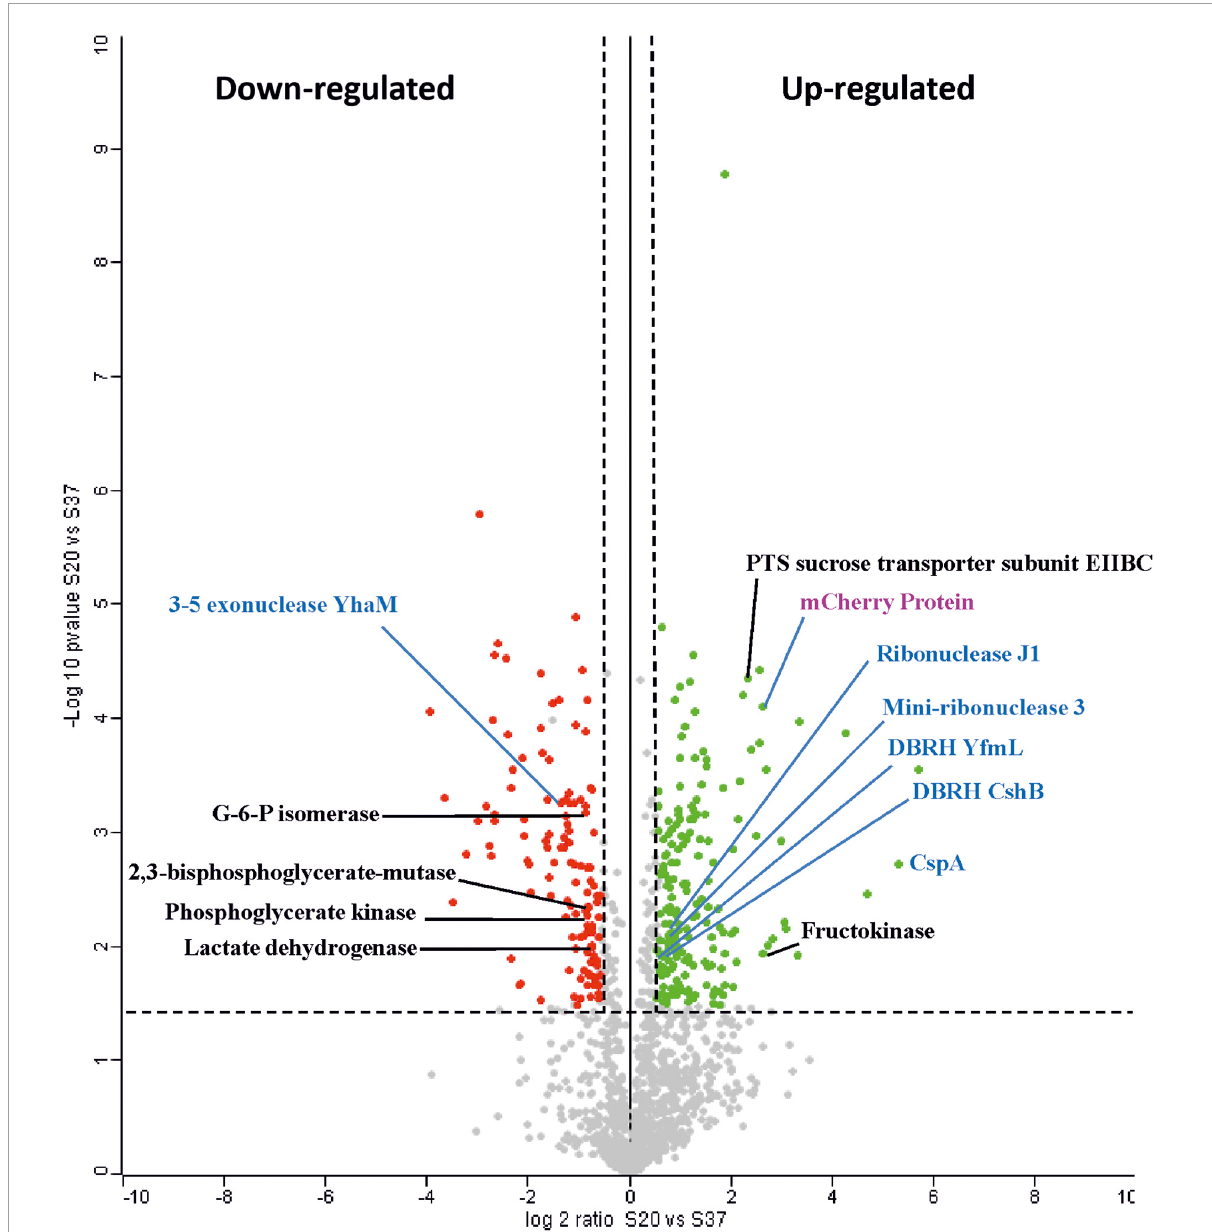
FIGURE2 Volcano plot of upregulated and downregulated proteins in Lc. lactis AV1n[pRCR21] cultures grown to 20 ◦ C vs. 37 ◦ C. A test comparison of 1,385 quantified proteins was performed. Only proteins with a differential expression level in the range ± 10 are shown ( Supplementary Table 1 ). The x -axis is log2 ratio of protein expression differences between two groups (S20 ◦ C vs. S37 ◦ C), and the y -axis is the p- value based on − log10. Red circles indicate differentially expressed proteins (downregulated), and green circles indicate differentially expressed (upregulated). Gray dots indicate non-differentially expressed proteins. The dashed horizontal line indicates the threshold of the adjusted p -value ≤ 0.05, FDR 5%, whereas dashed vertical lines enclose an area with a log2 ratio ± 0.58 (i.e., ratio ≥ 1.5 or ≤ 0.67). Blue color is used to group proteins involved in cold shock response, whereas black color is for those involved in carbohydrate metabolism. The mCherry protein is denoted in purple